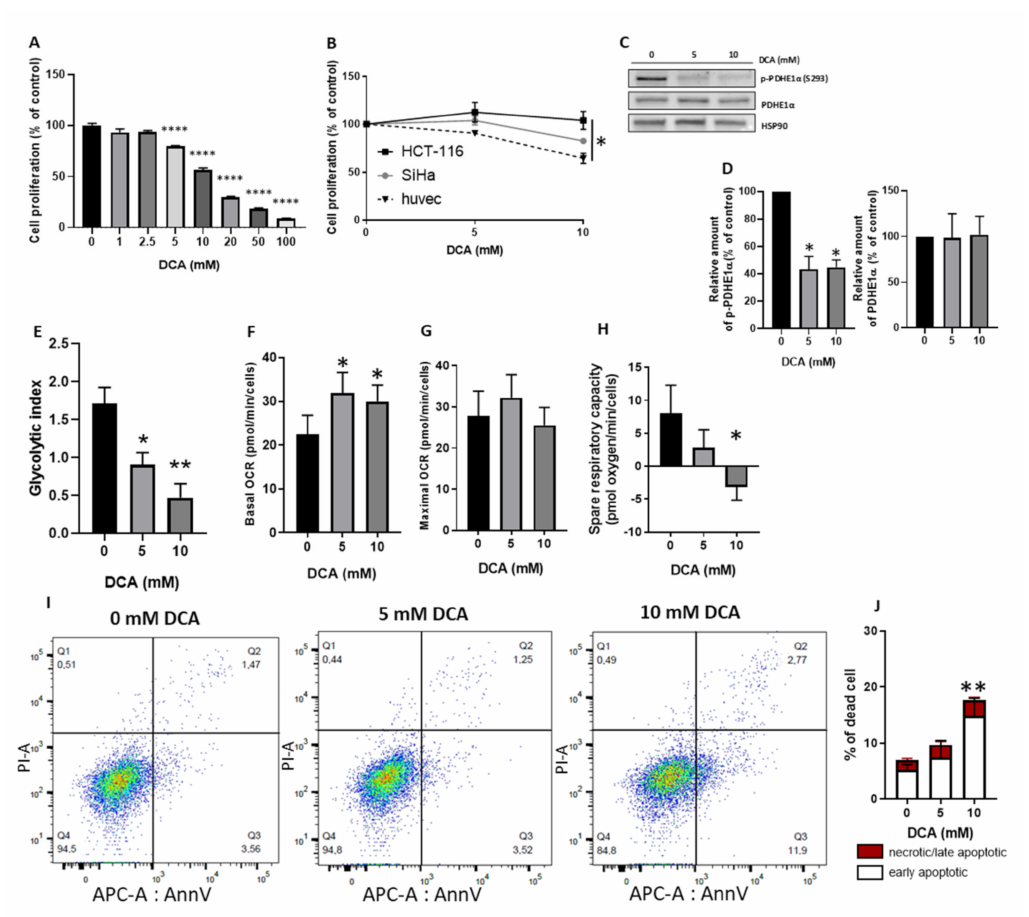
Figure 1. DCA reduces HUVECs proliferation and, through PDH activation, induces a metabolic shift towards decrease in glycolysis and in spare respiratory capacity. ( A ) proliferation of HUVECs exposed to increasing doses of DCA (0–100 mM) ( n = 4). ( B ) comparison of the e ff ect of DCA exposure on cell proliferation between cancer cells (HCT-116 and SiHa) and HUVECs ( n = 3). ( C ) representative immunoblotting of total (PDHE1 α ) and phosphorylated ( p -PDHE1 α ) form of PDH in HUVECs after exposure to 0, 5 or 10 mM DCA ( n = 3). ( D ) densitometry analysis of p -PDHE1 α and PDHE1 α . ( E ) lactate production from glucose in control and DCA treated HUVECs (5 and 10 mM DCA); results are presented as ratio of total lactate (sum of intra-and extracellular lactate) on glucose uptake ( n = 3). ( F , G ), oxygen consumption rate ( F , basal OCR and G , maximum OCR) measured in HUVECs treated with or without DCA (5 and 10 mM) ( n = 3). ( H ) spare respiratory capacity (maximal OCR minus basal OCR). ( I ) representative AnnexinV / PI flow cytometry plots of HUVECs treated with or without 5 or 10 mM of DCA. ( J ) histograms of apoptotic and dead cells ( n = 4). Statistical analysis: One-way ( A , D – H ), or Two-way ANOVA ( J ) (Sidak’s multiple comparison test), * p < 0.05, ** p < 0.01, **** p <